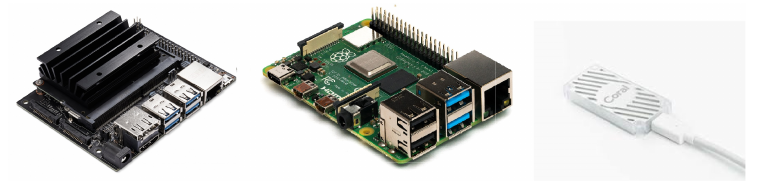
Figure 3. From left to right: Jetson nano, Raspberrypi, and Google TPU Coral.